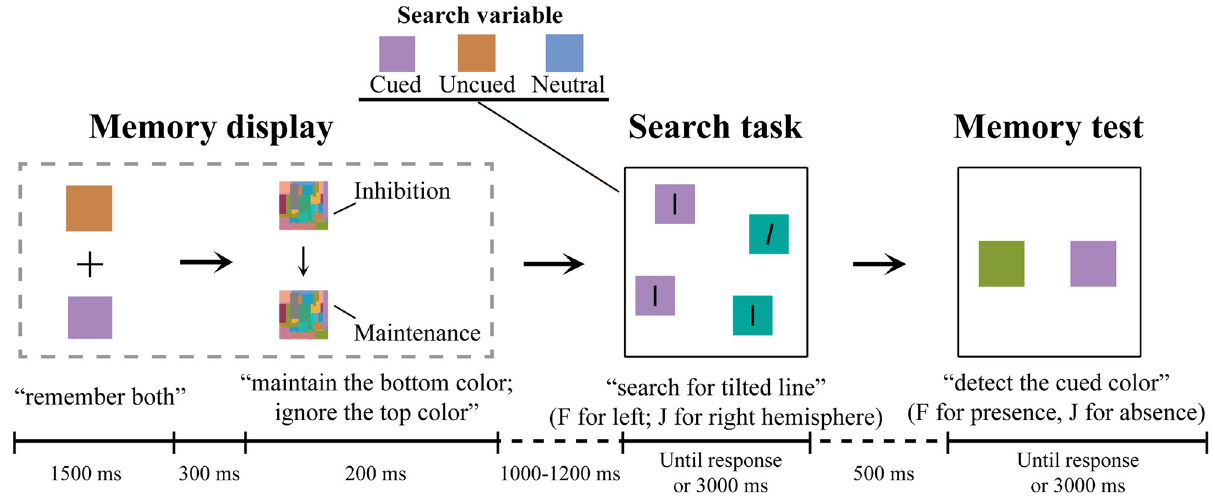
Fig 1. Schematic illustration of the trial sequence, stimulus displays, and response requirements in the present study. The Search variable (cued, uncued, and neutral colors) was presented contralateral to the search